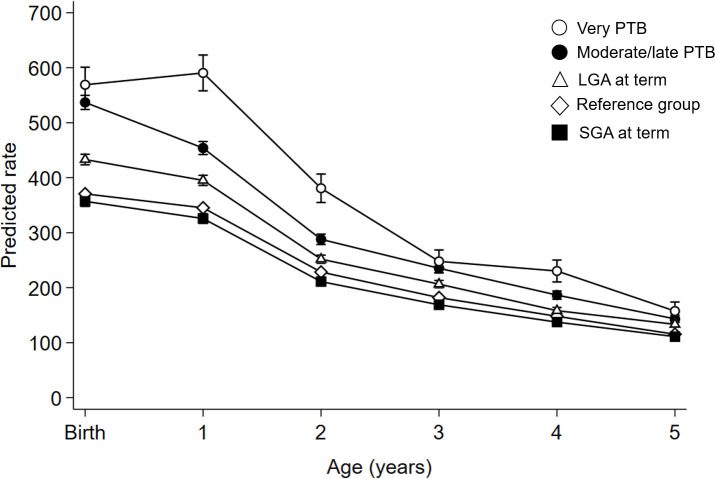
Age-specific trajectories of respiratory health service utilization rates from birth to five years of age for birth groups.Reference group = appropriate-for-gestational age infants born at term; LGA = large for gestational age; PTB = preterm birth; SGA = small for gestational age. Rates expressed as number of events per 1,000 singleton live births. Bars express 95% confidence intervals.